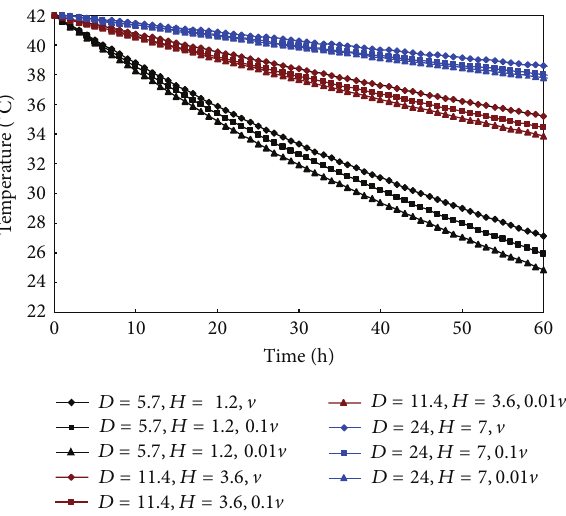
Figure 22: Evolution of mean temperature versus viscosity. Figure 23: Evolution of mean temperature versus Cp.